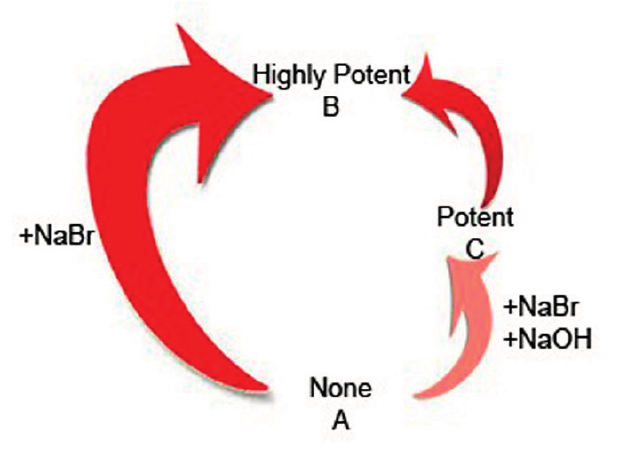
Figure 2. Bactericidal effect on S. aureus and P. aeruginosa